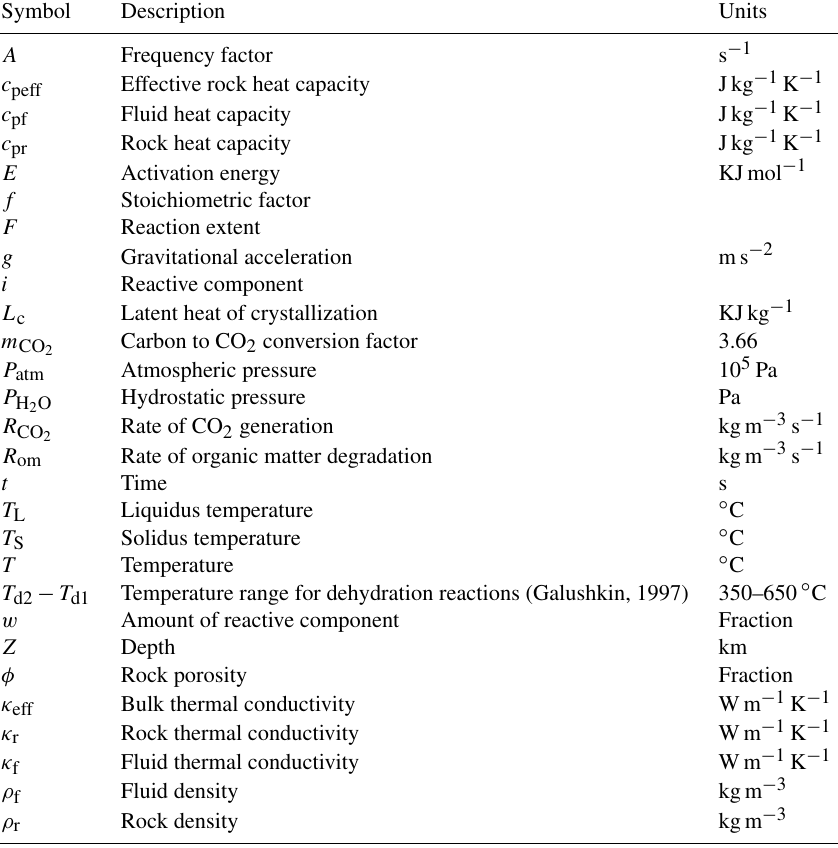
Table 1. Definition of symbols used in the